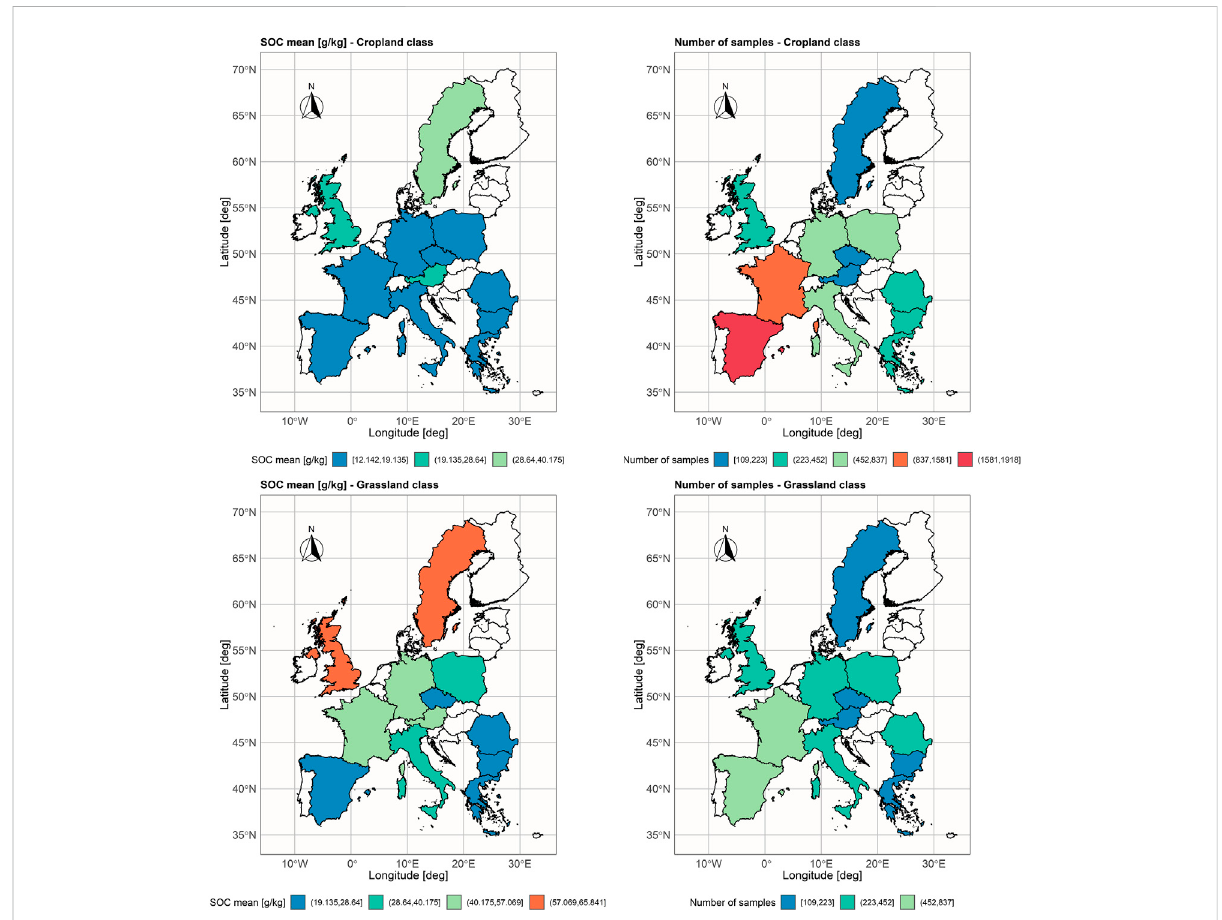
FIGURE 2 Spatial distribution of mean SOC values [g/kg], and number of samples aggregated per country in LUCAS-12 data